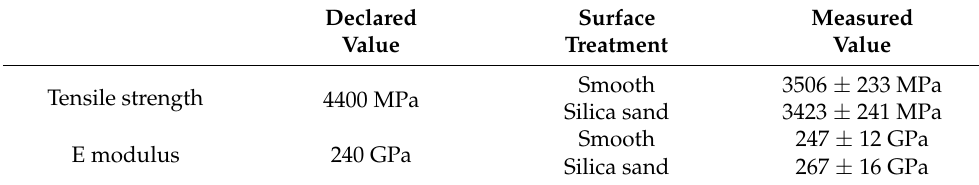
Table 2. Comparison of declared and measured values.